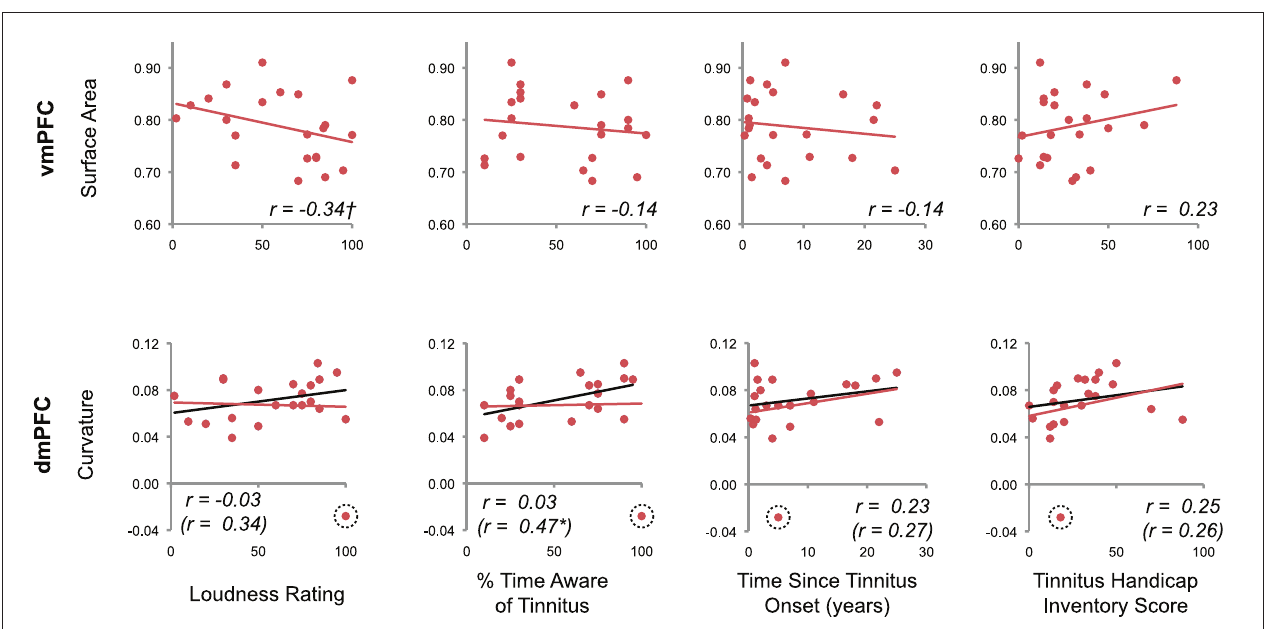
area and tinnitus loudness ( † p = 0 . 06, one-tailed test). A significant correlation was also apparent between dmPFC curvature and the percentage of time patients reported being aware of their tinnitus after removal of a statistical outlier (* p = 0 . 02, one-tailed test). Black regression lines and r statistics in parentheses reflect the results of correlation analyses performed after removing this